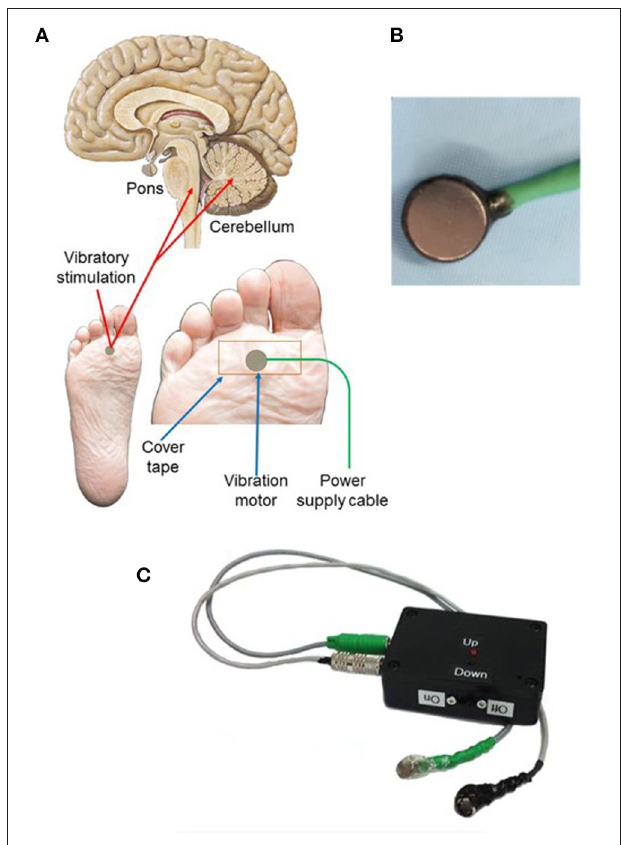
FIGURE 2 | (A) Placement of vibrator motor on the sole of the foot; since the limb movement/breathing reflex is operative on all four limbs (from early origins of the reflexive coupling), placement on the palm of the hand is also effective. The activated proprioceptive fibers project to the cerebellum and parabrachial pons, that in turn, integrate with motor action to the upper airway and diaphragm. (B) Vibrator motor with power lead. (C) Power supply containing two 1.5-volt fused AA batteries with two levels of vibratory stimulation. From